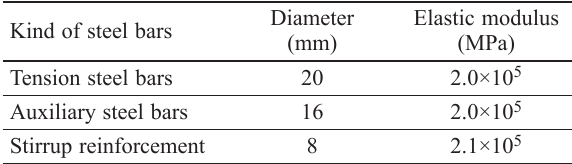
Table 1. Mechanical parameters of different steel bars